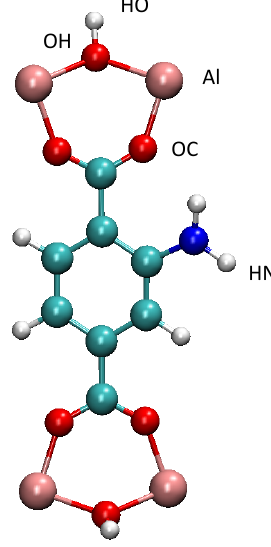
Figure 2. Cluster of atoms used in the charge calculation [34]. Labels of atoms (OH, HO, Al, OC, HN) implicated in the radial distribution functions’ calculation are also